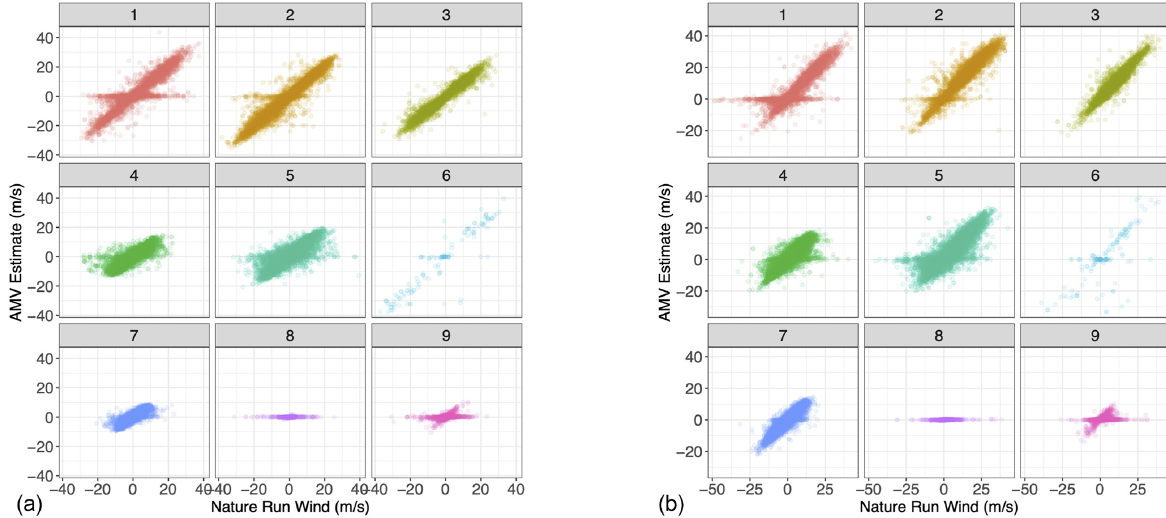
Figure 13. Scatterplot of Nature Run wind vs. AMV estimates, each sub-panel corresponding to the specific Gaussian mixture component to which each point in the testing set has been assigned when the Nature Run wind value has been substituted by the random estimate. (a) u -direction wind; (b) v -direction wind.